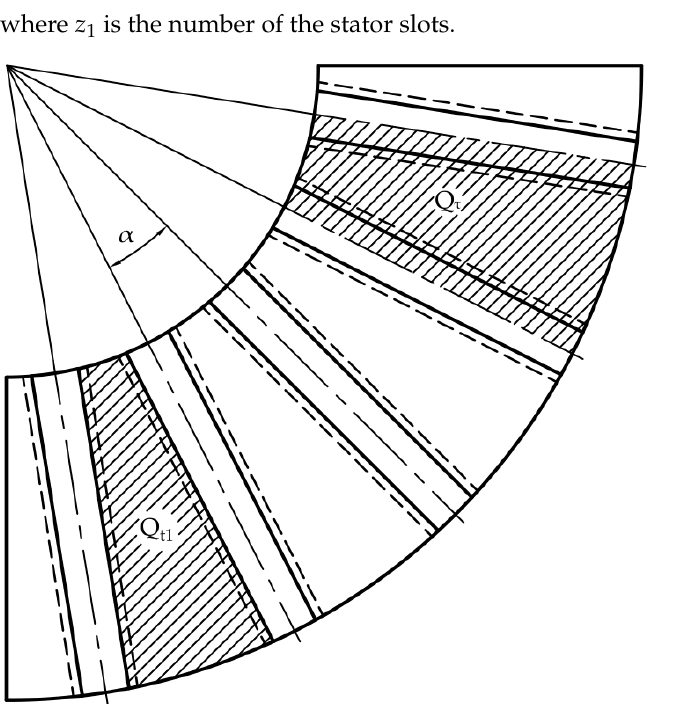
Figure 2. Stator tooth zone in the plane of the air